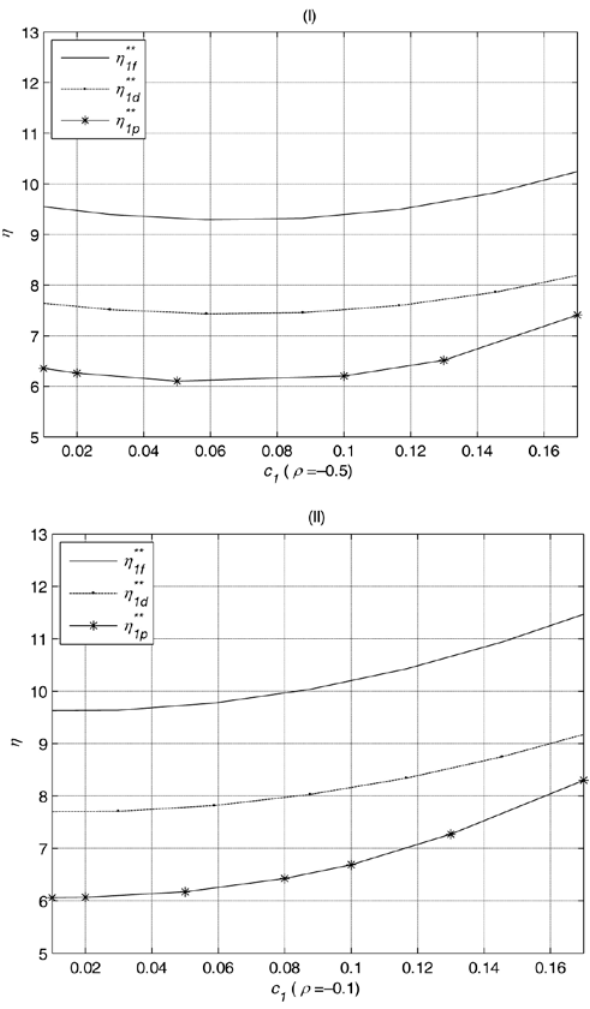
fig. 2. Impacts of c on investment thresholds of agent 1 1 note: all the parameter values are set as follows: r = 0.05, I = 100, D (1) = 1, D (2) = 0.8, µ = 0.02, a i = 0.01, a j = 0.01, σ = 0.2, and c = 0.1 . j